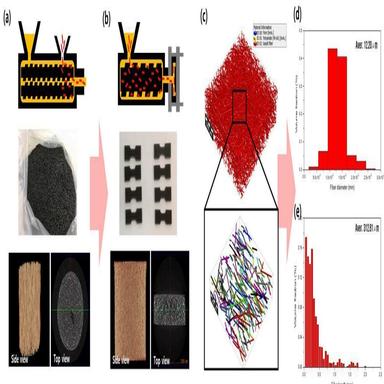
Internal microstructural characterization of the fiber diameter and length distribution in the SBF/PA6,6 composites. Internal microstructure after (a) extrusion and (b) injection molding, respectively. (c) Individual fiber identification to determine the (d) fiber diameter and (e) length distribution.